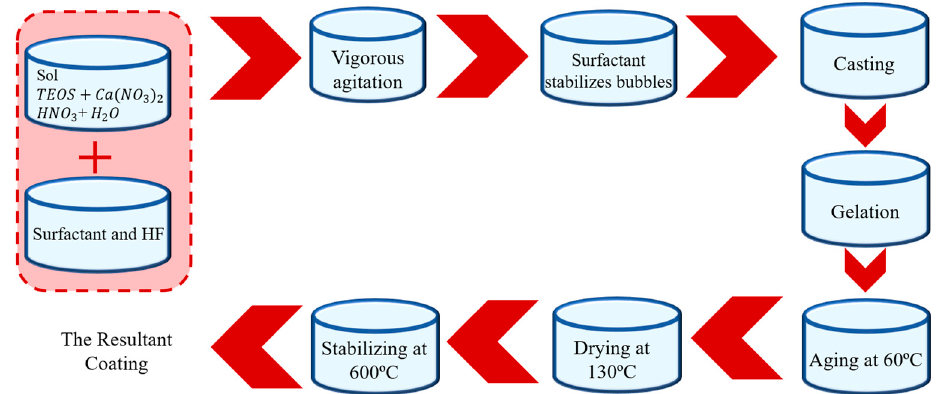
Figure 7. Schematic sol–gel coating process from solution preparation to the final solid structure